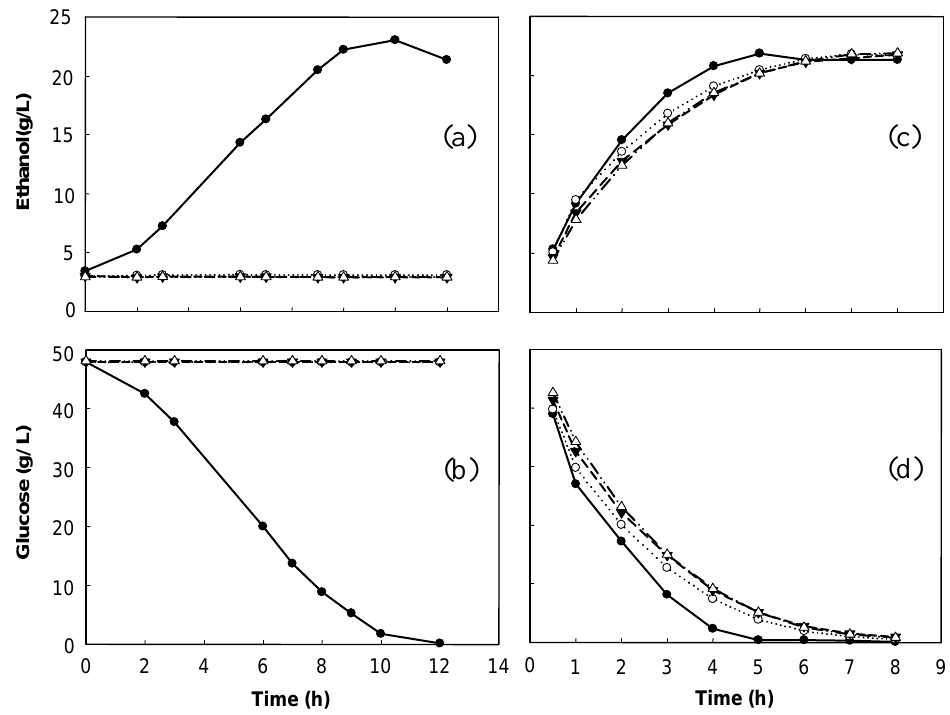
Figure 1. Glucose and ethanol concentration in anaerobic batch cultivation with suspended (a,b) and encapsulated S. cerevisiae (c,d), where limonene with different concentrations of